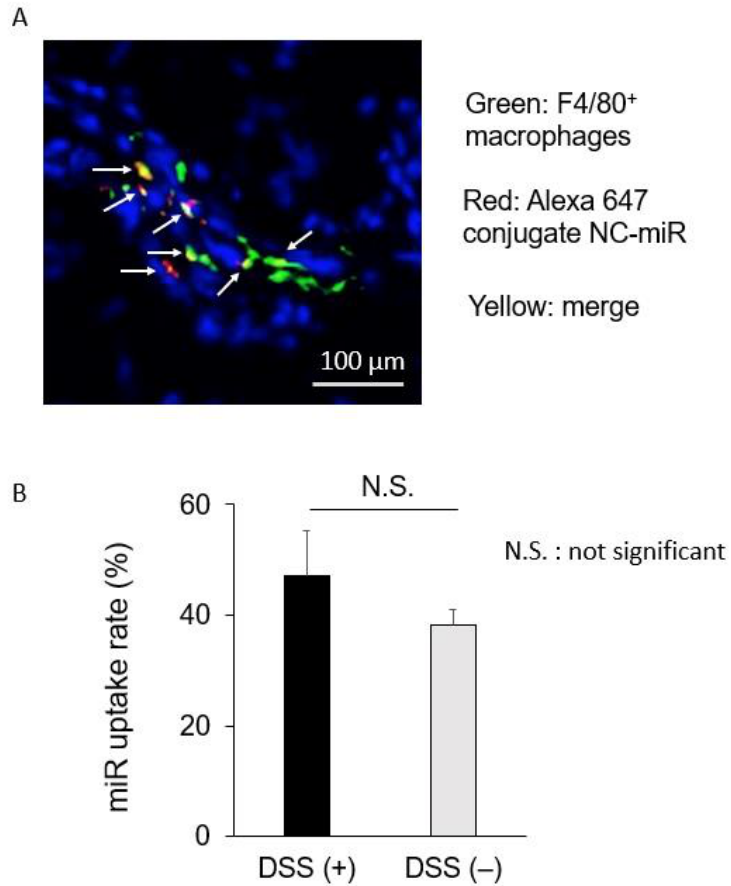
Figure 6. Co-localization of miRNA with macrophages in colonic mucosa. DSS-induced colitis was produced by free drinking of 2% DSS for 7 days in female mice ( n = 2). sCA incorporating miR-NC tagged with Alexa Fluor 647 (25 µ g) was administered via tail vein, and the colon was excised 4 h after administration. Immunostaining of macrophages with the anti-F4/80 antibody showed that co-localization of miRNA with the F4/80 positive-macrophages was noted 47.12 ± 8.27 in inflamed colon by DSS treatment and 38.23 ± 2.79 in normal mucosa, respectively ( n = 6 per mice). Scale bar, 50 µ m. Red: miR-NC tagged with Alexa Fluor 647, Green: F4/80 positive-macrophages. Yellow: merged signals, indicated by